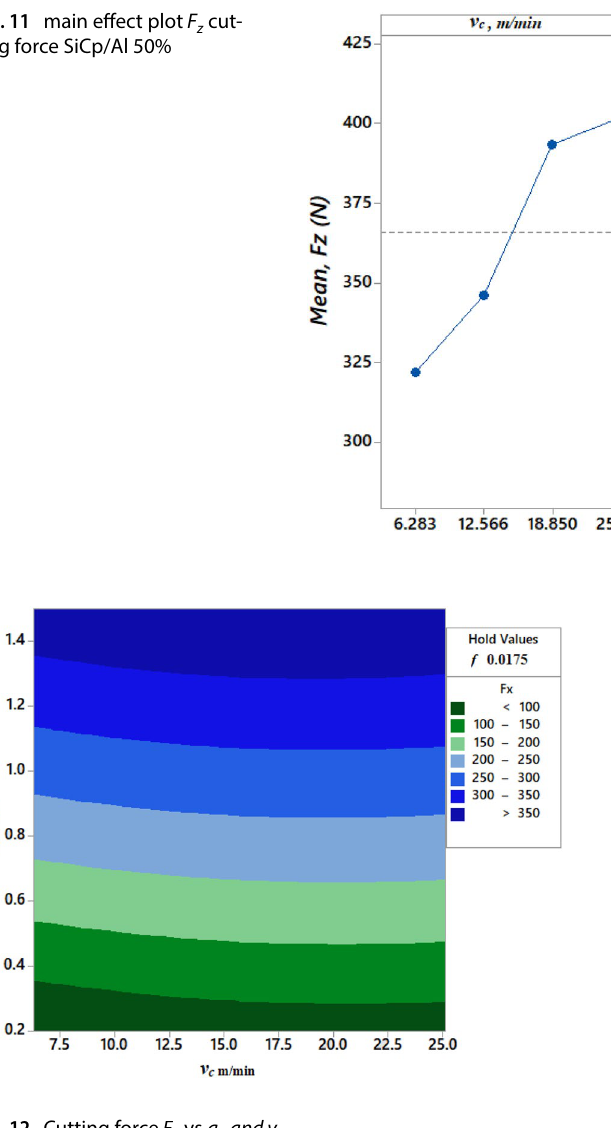
Fig. 12 Cutting force F x vs a